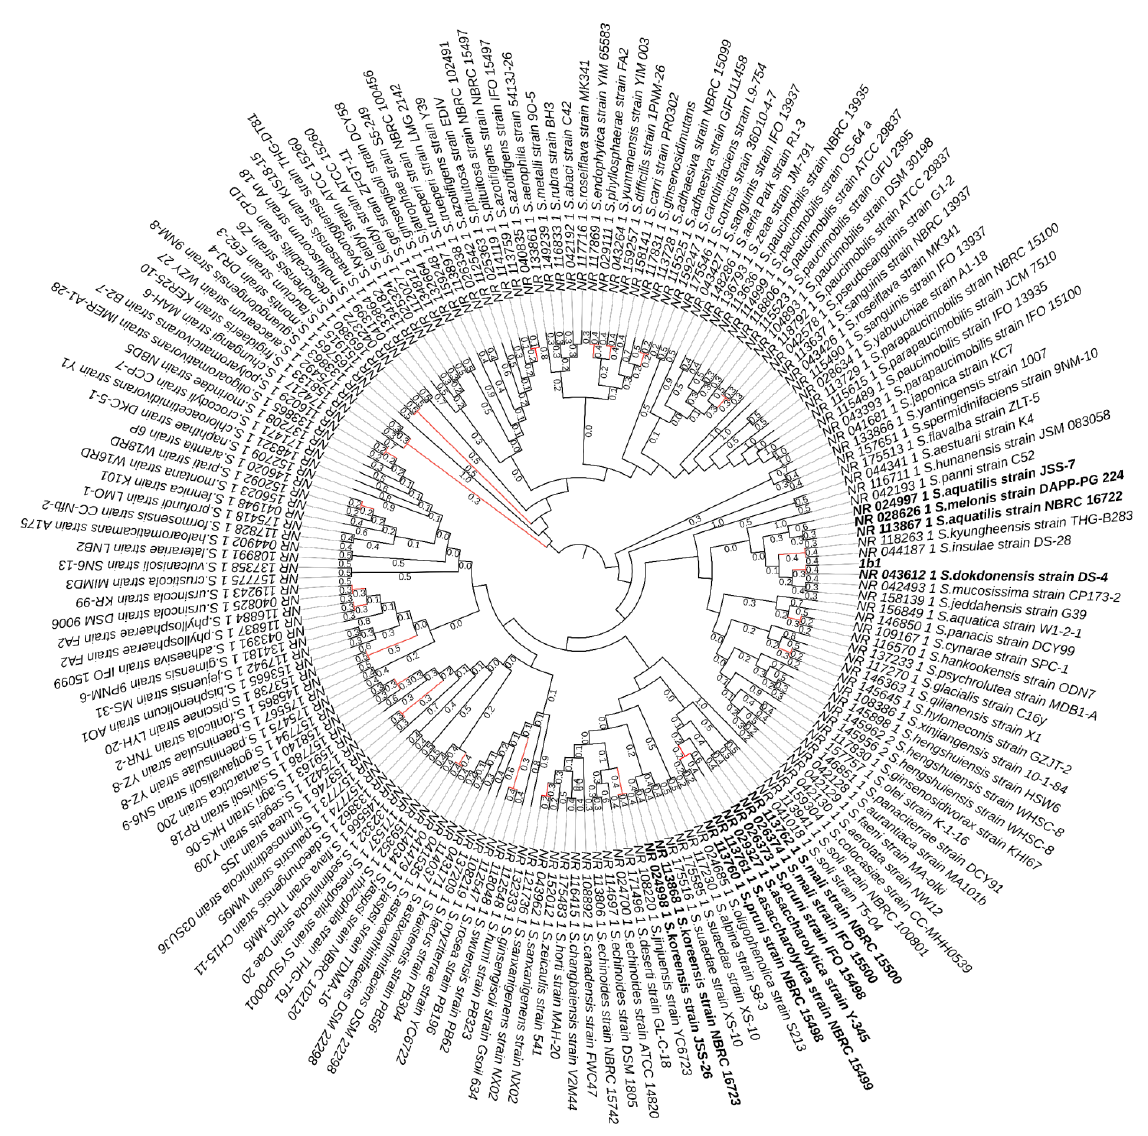
Figure 2. Species delimitation tree generated by the Bayesian Poisson tree processes (bPTP) model, using a fragment of the 16S rDNA. Black lines indicate branching processes among species, red lines indicate branching processes within species. Support values shown on the tree branches represent the posterior probabilities of those taxa forming one species. In bold are represented the tested Sphingomonas spp .